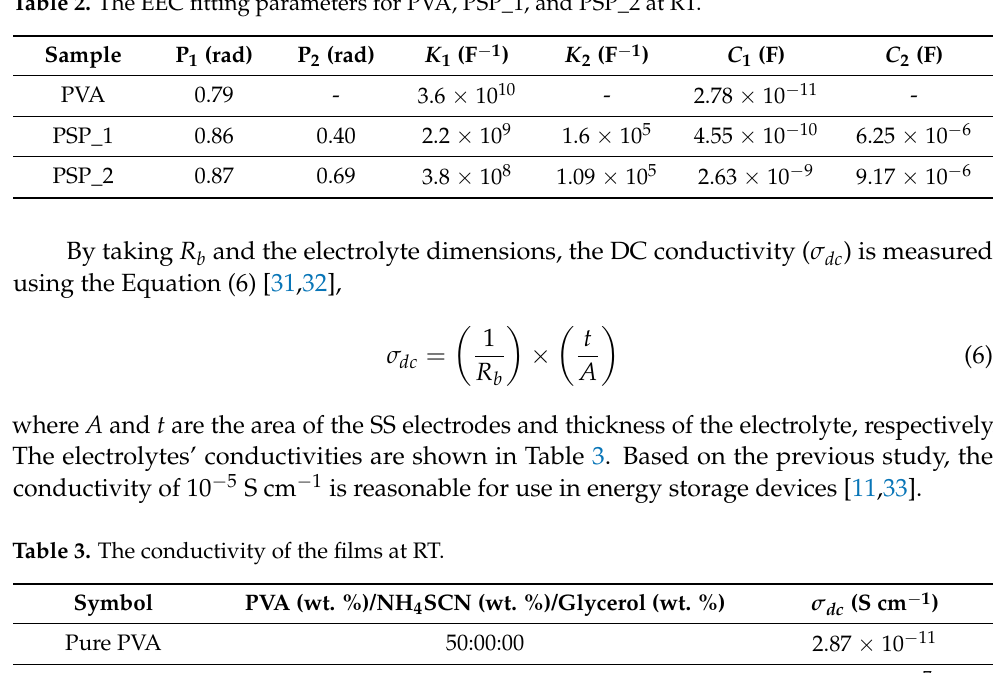
Table 2. The EEC fitting parameters for PVA, PSP_1, and PSP_2 at RT.